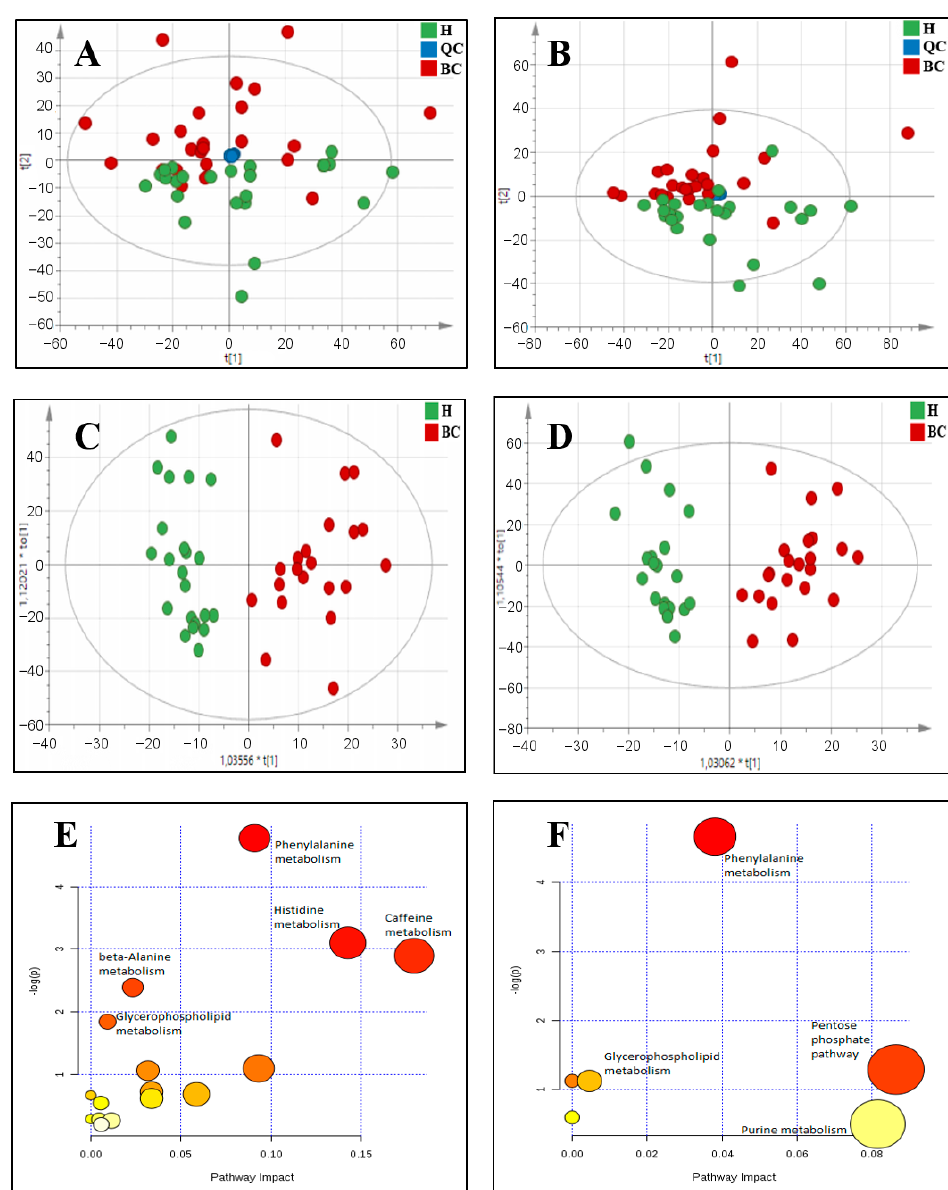
Figure 1. Observed differences in metabolic profiles of control and BC patients: ( A ) PCA score plot for positive ionization mode, with PC1 describing 12.8% of the variation and PC2 describing 5.5%, ( B ) PCA plot for negative ionization mode, with PC1 describing 13.6% of the variation and PC2 describing 5.5%, ( C ) Score plot of OPLS-DA model for positive ionization mode, with R2 = 85.2% and Q2 = 46%, ( D ) Score plot of OPLS-DA model for negative ionization mode, with R2 = 88.2% and Q2 = 43.3%, ( E ) Pathway analysis of differential metabolites in positive ionization mode, ( F ) Pathway analysis of differential metabolites in negative ionization mode.